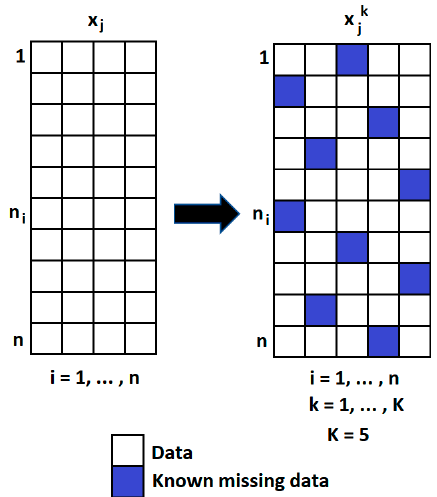
Figure 3. Extraction of known values and substitution for missing values.